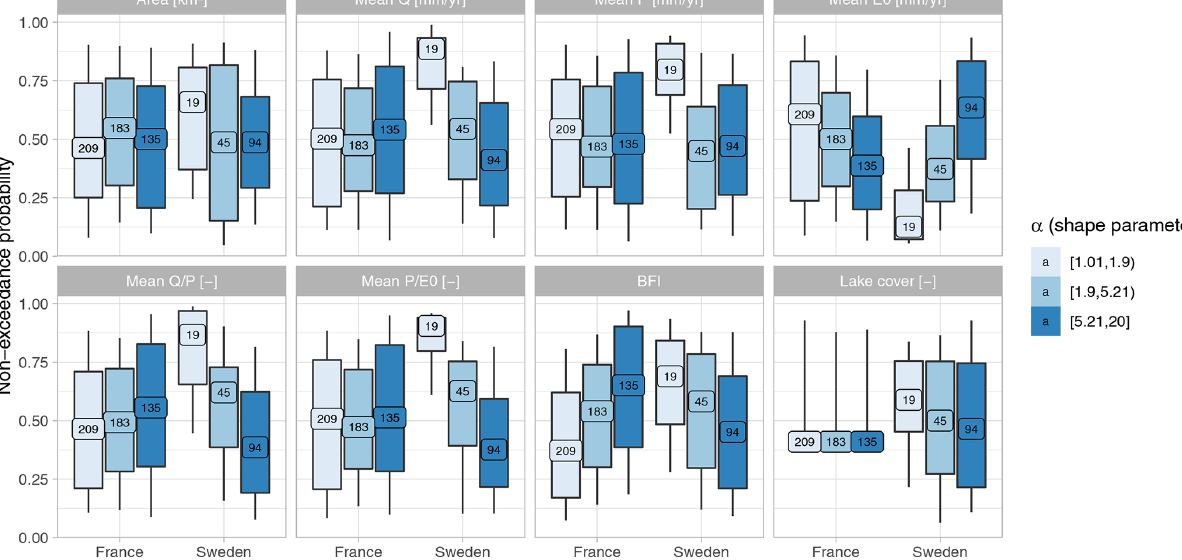
Figure B2. Distribution of hydroclimatic characteristics according to three classes of the shape parameter α of the Gamma distribution (Eq. 3) calibrated inside Eq. (2). The classes are delimited by quantile values. The numbers within each boxplot describe the number of